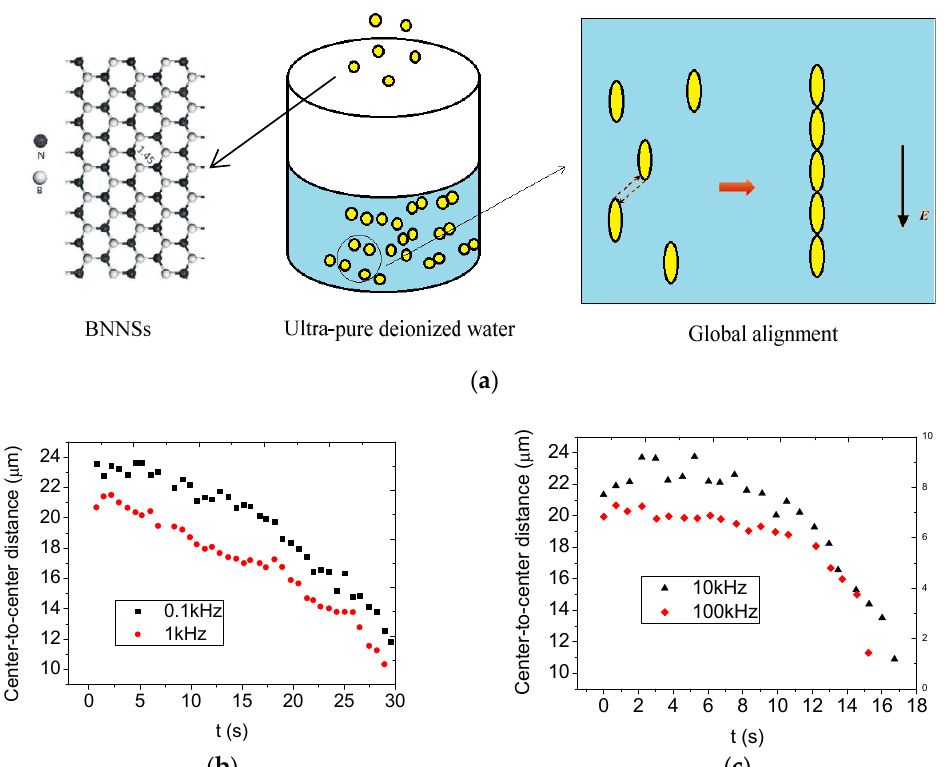
Figure 1. Schematics of global alignment of BNNSs under nanosecond pulses. ( a ) is the experimental setup and global alignment phenomenon. ( b , c ) are the experimental results under 0.1, 1, 10 and 100 kHz [4], respectively.